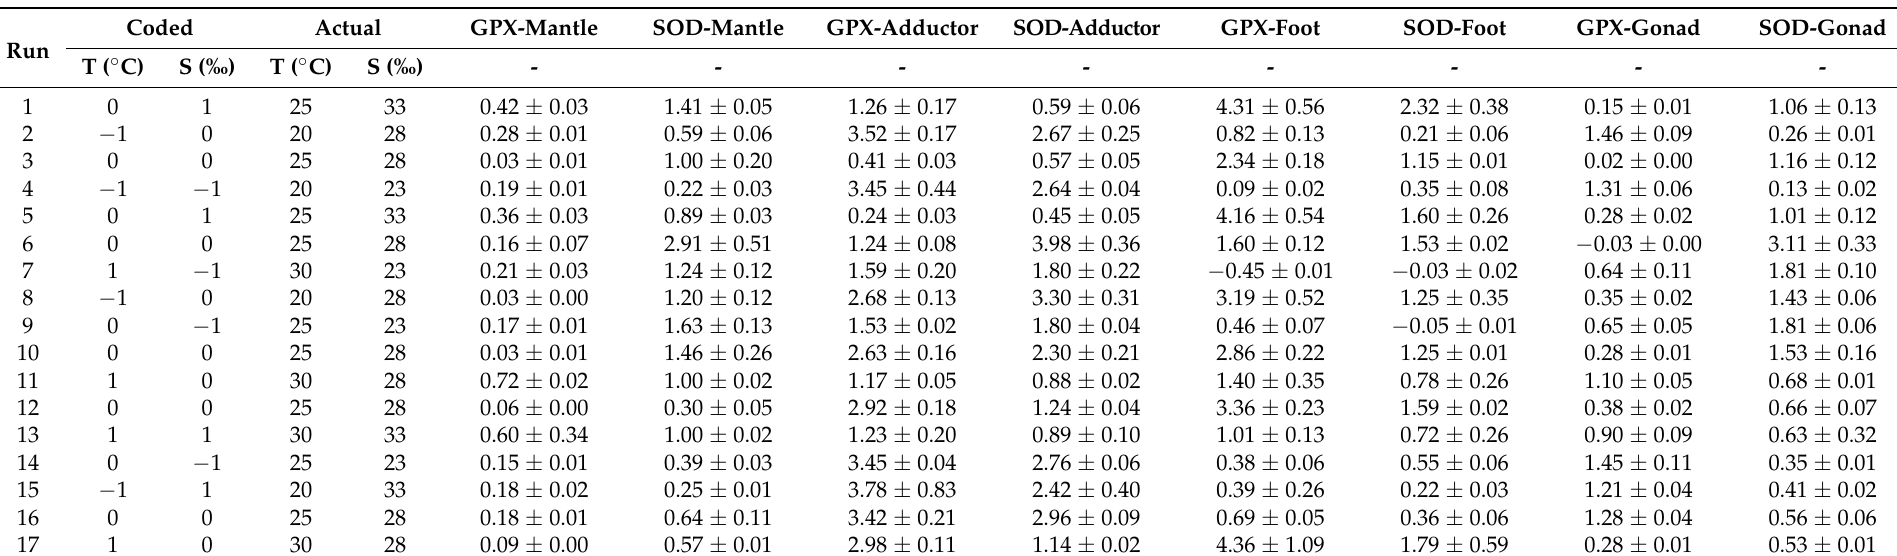
Table 3. Experimental design and results of the relative expression of antioxidant genes’ response